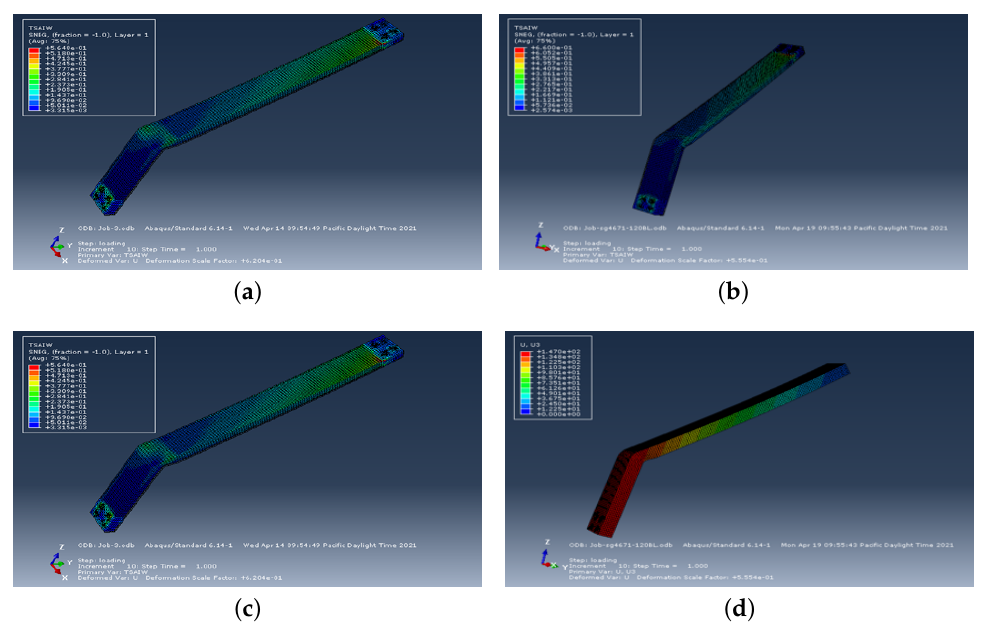
Figure 11. Results of Tsai-Wu failure criterion and deflection of main landing gear struts composed of T300 carbon fiber/epoxy and S-glass fiber/epoxy under two point landing load condition. ( a ) Tsai-Wu failure criterion of main landing gear strut composed of T300 carbon fiber/epoxy. ( b ) Tsai-Wu failure criterion of main landing gear strut composed of S-glass fiber/epoxy. ( c ) Deflection of main landing gear strut composed of T300 carbon fiber/epoxy. ( d ) Deflection of main landing gear strut composed of S-glass